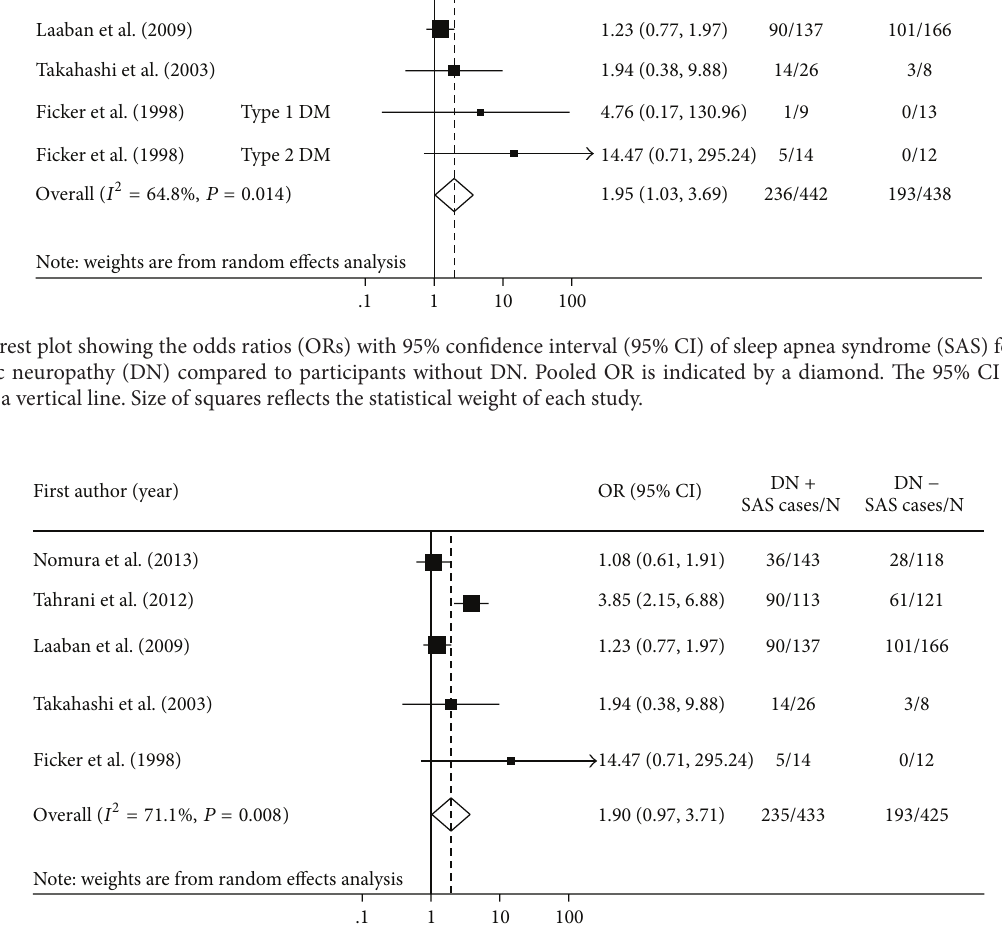
Figure 2: Forest plot showing the odds ratios (ORs) with 95% confidence interval (95% CI) of sleep apnea syndrome (SAS) for participants with diabetic neuropathy (DN) compared to participants without DN. Pooled OR is indicated by a diamond. The 95% CI of each OR is indicated by a vertical line. Size of squares reflects the statistical weight of each